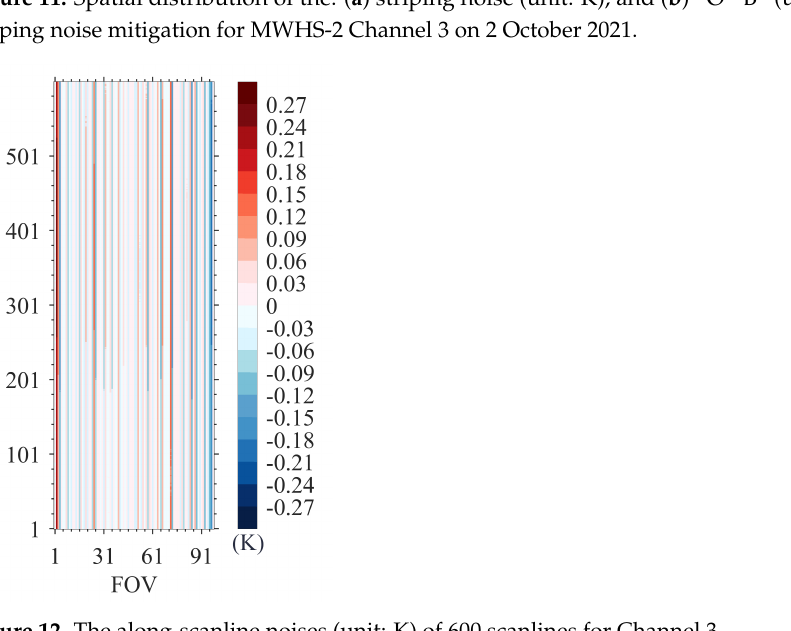
Figure 12. The along-scanline noises (unit: K) of 600 scanlines for Channel 3. The biases of each channel after noise mitigation are shown in Figure 13. Originally, the biases for all the channels have high-frequency oscillations along the scanlines, with ba- sically the same oscillation directions. After the brightness temperature reconstruction, the overall trend of the biases with FOVs does not change, but the high-frequency oscillations are eliminated to some extent, indicating that the along-scan noises are suppressed